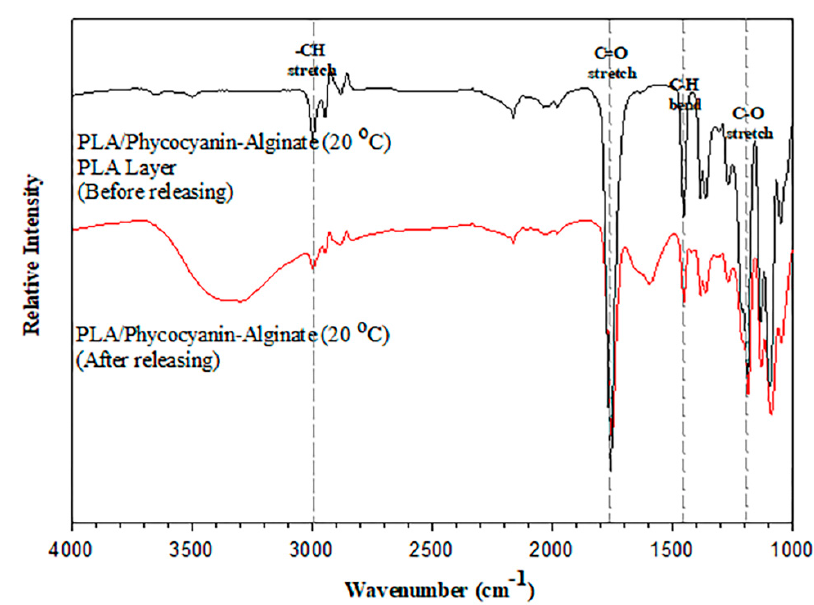
Figure 10. Attenuated total reflectance (ATR)–FTIR spectra for PLA / phycocyanin–alginate composites (20 °C) before and after the releasing test.